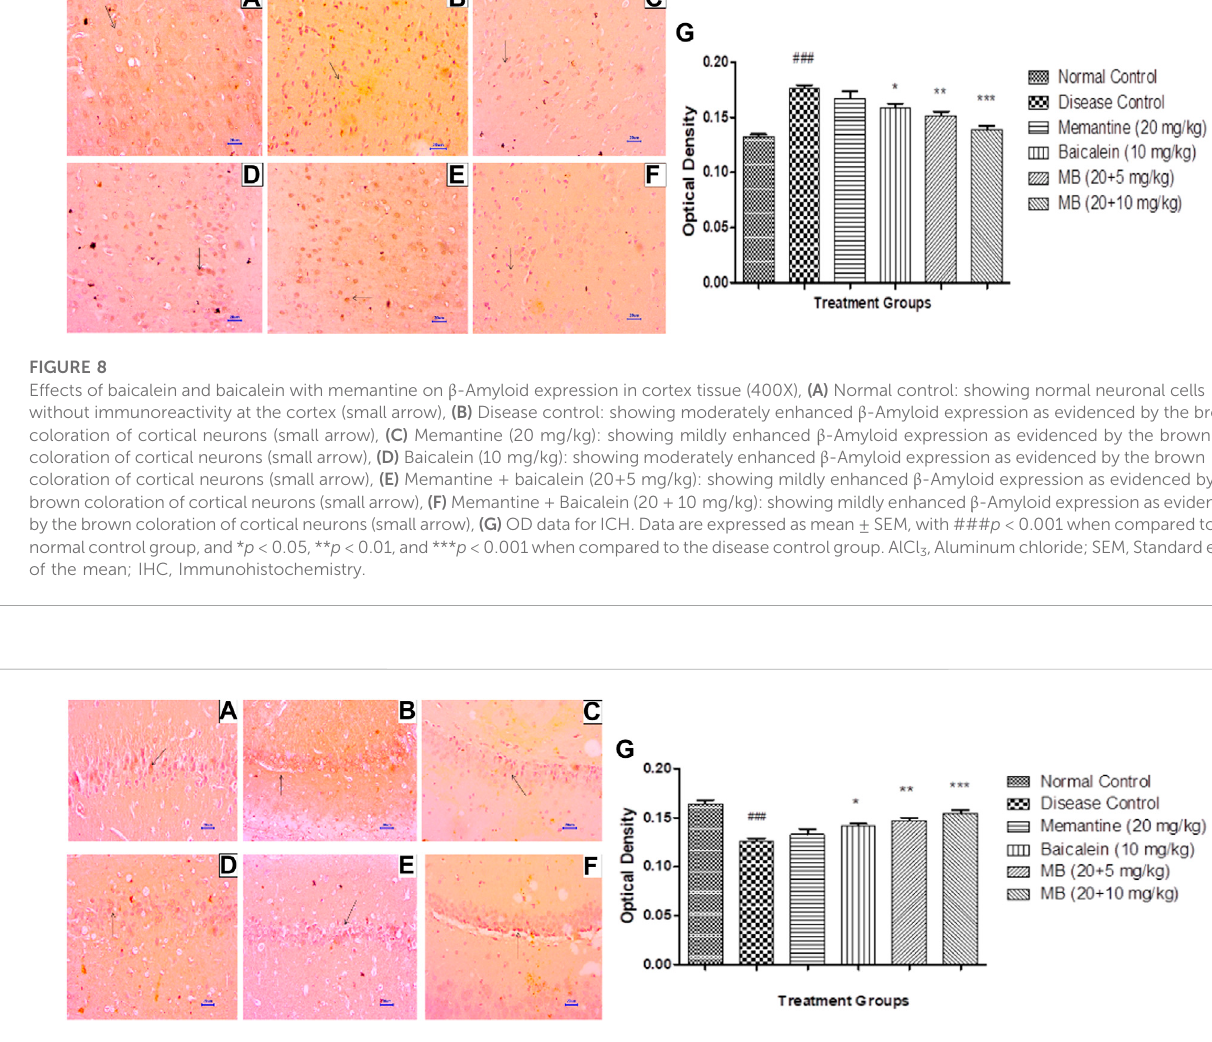
FIGURE 9 EffectsofbaicaleinandbaicaleinwithmemantineonBDNFexpressioninhippocampustissue(400X), (A) Normalcontrol:showingmoderatelyenhanced BDNF expression, as evidenced by the brown coloration of hippocampus neurons (small arrow), (B) Disease control: showing mild BDNF expression, as evidenced by brown coloration at Hippocampus neurons (small arrow), (C) Memantine (20 mg/kg): showing moderately enhanced BDNF expression, as evidenced by the brown coloration of hippocampus neurons (small arrow), (D) Baicalein (10 mg/kg): showing mild BDNF expression, as evidenced by brown coloration of hippocampus neurons (small arrow), (E) Memantine + baicalein (20+5 mg/kg): showing moderately enhanced BDNF expression, as evidenced by brown coloration of hippocampus neurons (small arrow), (F) Memantine + baicalein (20 + 10 mg/kg): showing moderately enhanced BDNF expression, as evidenced by the brown coloration of hippocampus neurons (small arrow), (G) OD data for ICH. Data are expressed as mean ± SEM, with ### p < 0.001 when compared to the normal control group, and * p < 0.05, ** p < 0.01, and *** p < 0.001 when compared to the disease control group. AlCl 3 , Aluminum chloride; SEM, Standard error of the mean; BDNF, Brain-derived neurotrophic factor; IHC,